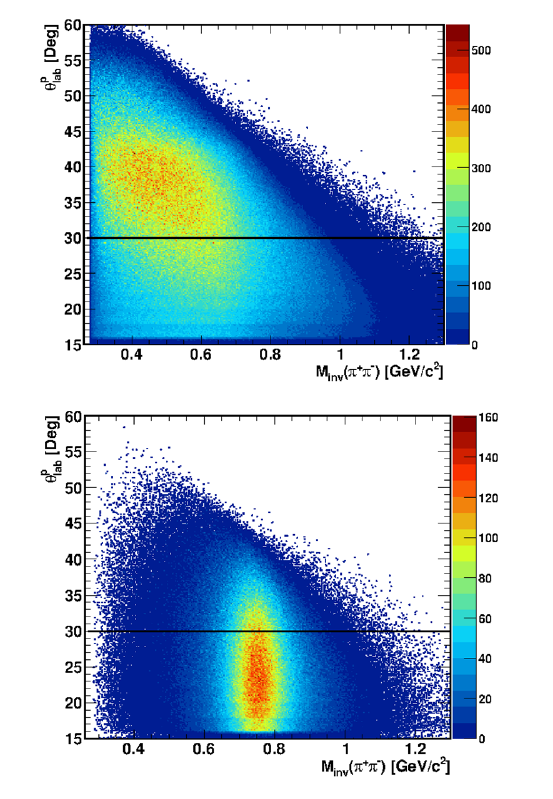
Figure 9. Correlation between the proton lab angle and the π + π − invariant mass for data (top) and for simulation of the pp → pp ρ reaction (bottom). The black line shows the second rejection ( θ p > 30 ◦ ) applied to enhance the ρ signal.